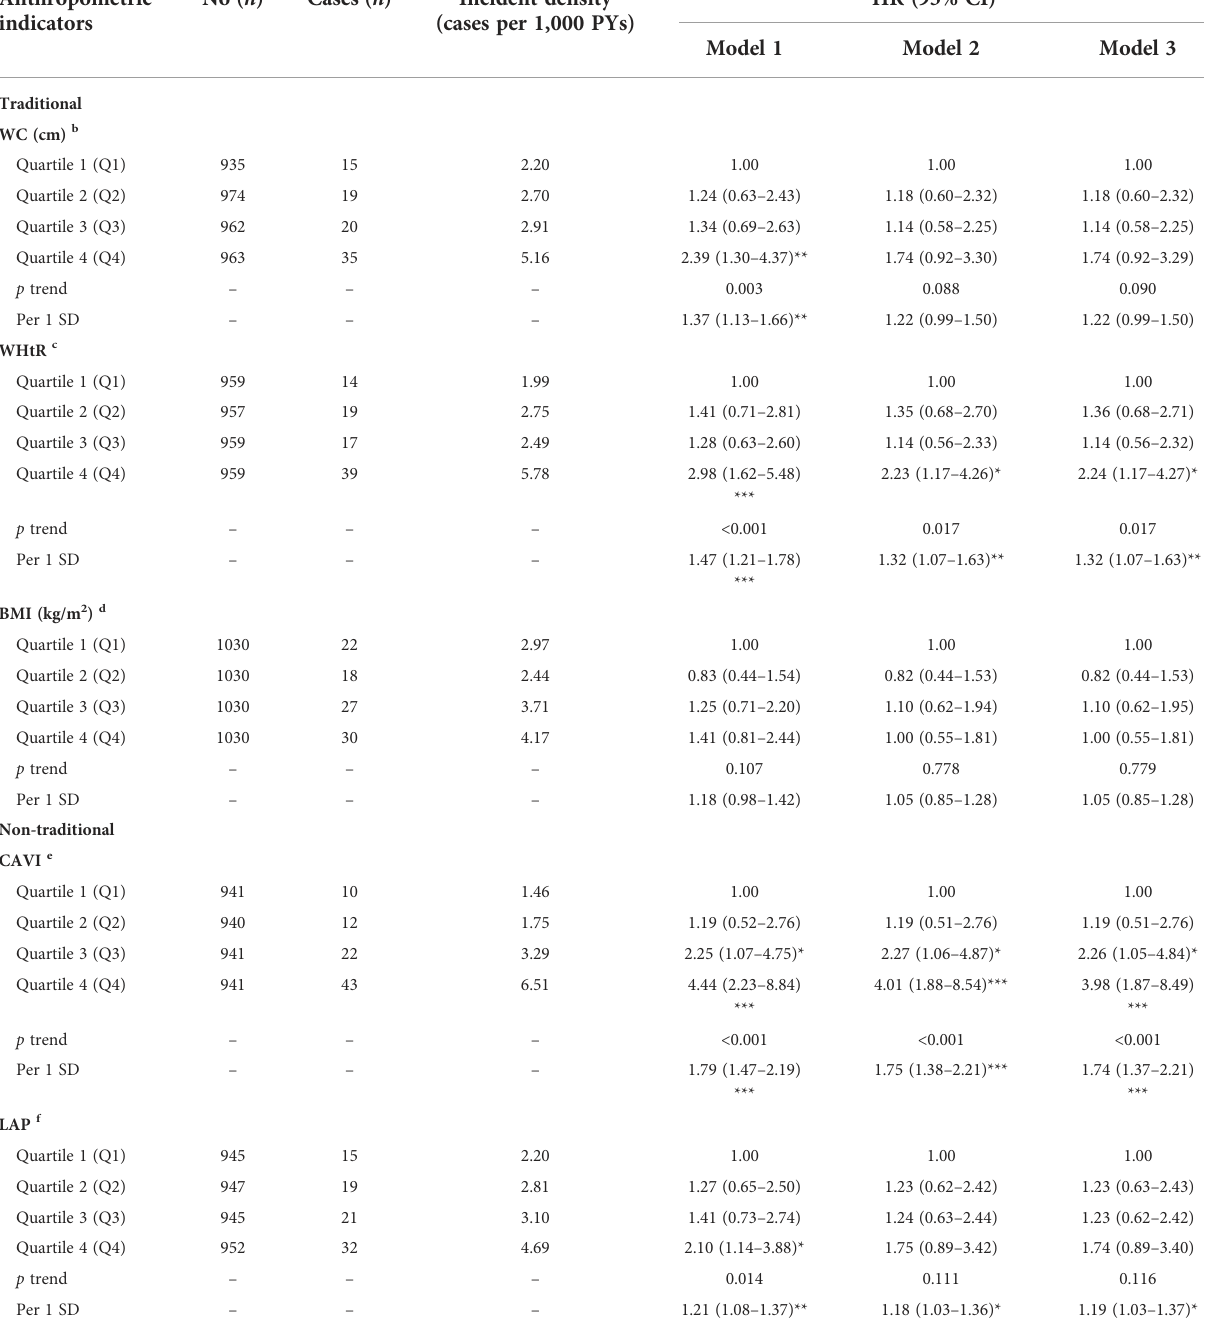
TABLE 4 Hazard ratios (HRs) and 95% con fi dence intervals (95% CIs) for overall CVDs associated with traditional and non-traditional anthropometric indicators among female participants ( n = 4,120) according to Cox regression